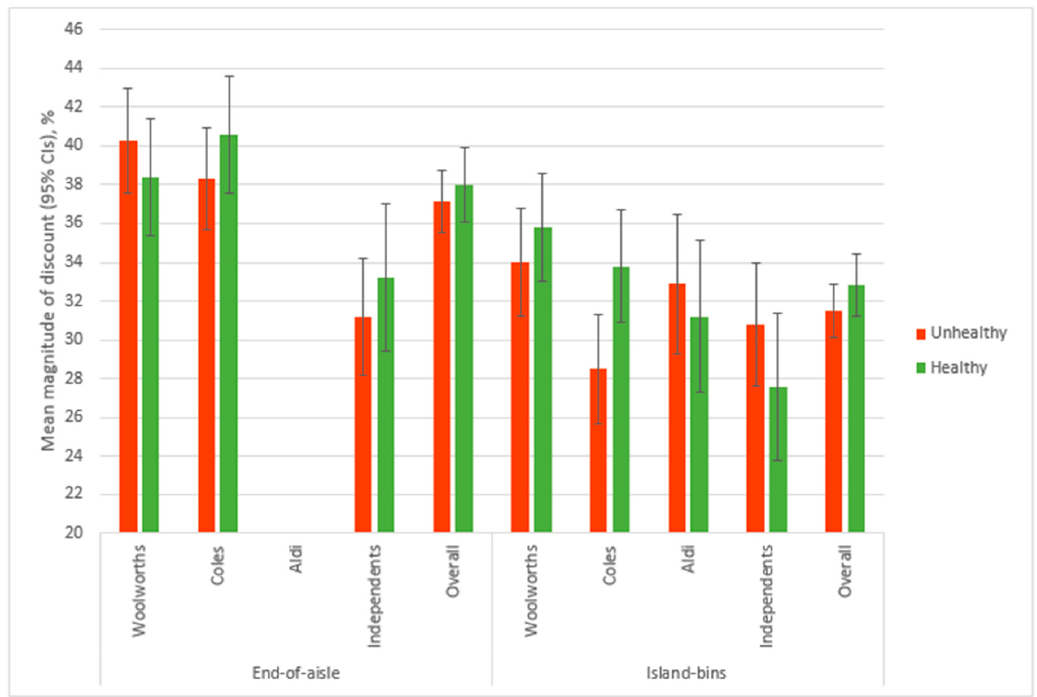
Figure 2. Mean magnitude of discount on food and beverage price promotions classified as healthy and unhealthy † at prominent in-store supermarket locations, by supermarket group in 2019. Figure depicts results of linear models that included supermarket group, SEP and interaction supermarket group by SEP. Aldi was not included in the linear model or overall mean % for end-of-aisle due to there being insufficient numbers of price promotions in those location. † Foods were classified as healthy or unhealthy based on the Australian Dietary Guidelines and the Australian Bureau of Statistics Discretionary Food List.